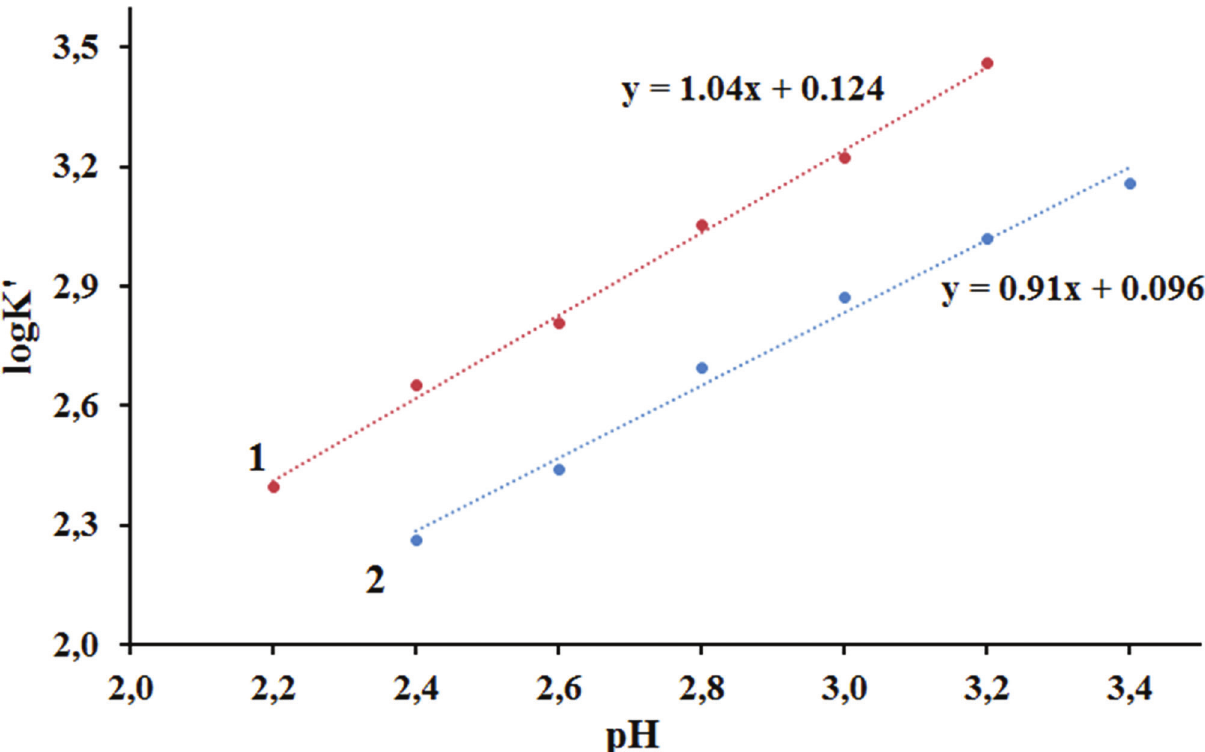
Figure 2: The pH-logK’ relationship for Pb 2+ -MSA ( 1 ) and Pb 2+ -morin ( 2 )